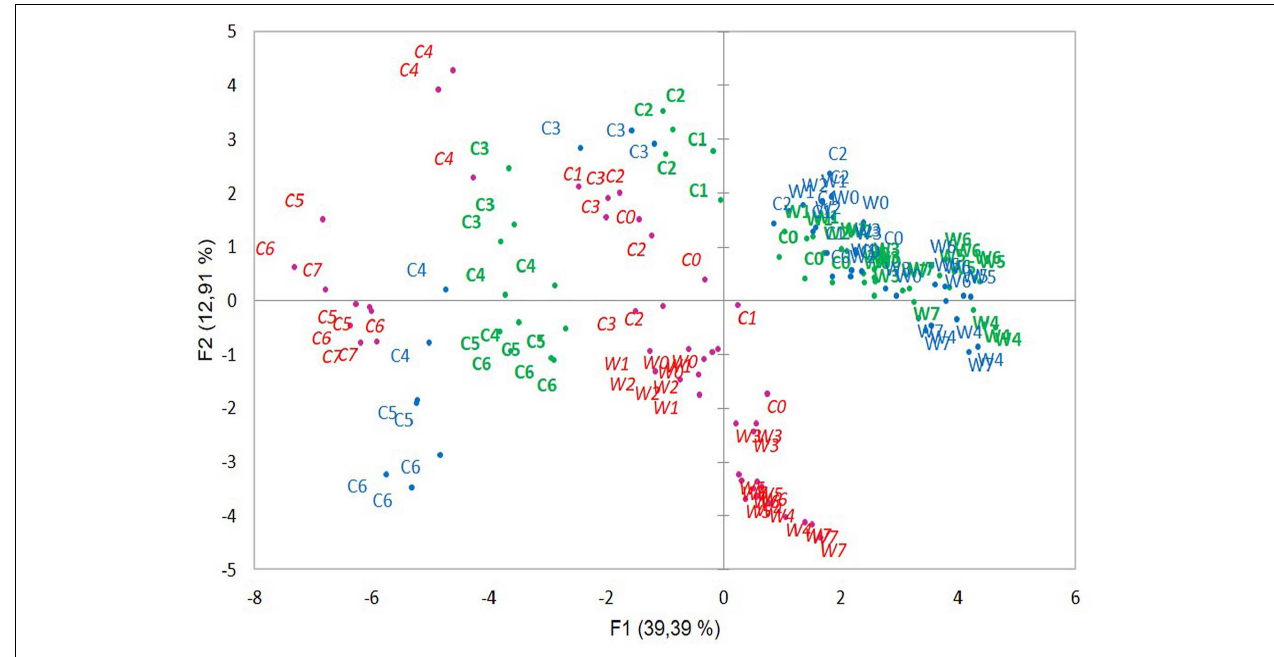
FIGURE 4 | Distribution of samples in the principal component analysis of samples from three B. cereus strains MM3 (italic red), ATCC 14579 T (blue), and ATCC 10876 (bold green). Codes for growth temperatures and growth time are same as in Figure 3 . TABLE 2 | Classification of fatty acids according to their patterns of changes during growth at cold and warm temperatures for three B. cereus strains ATCC 10876, ATCC 14579 T , and MM3. Patterns of